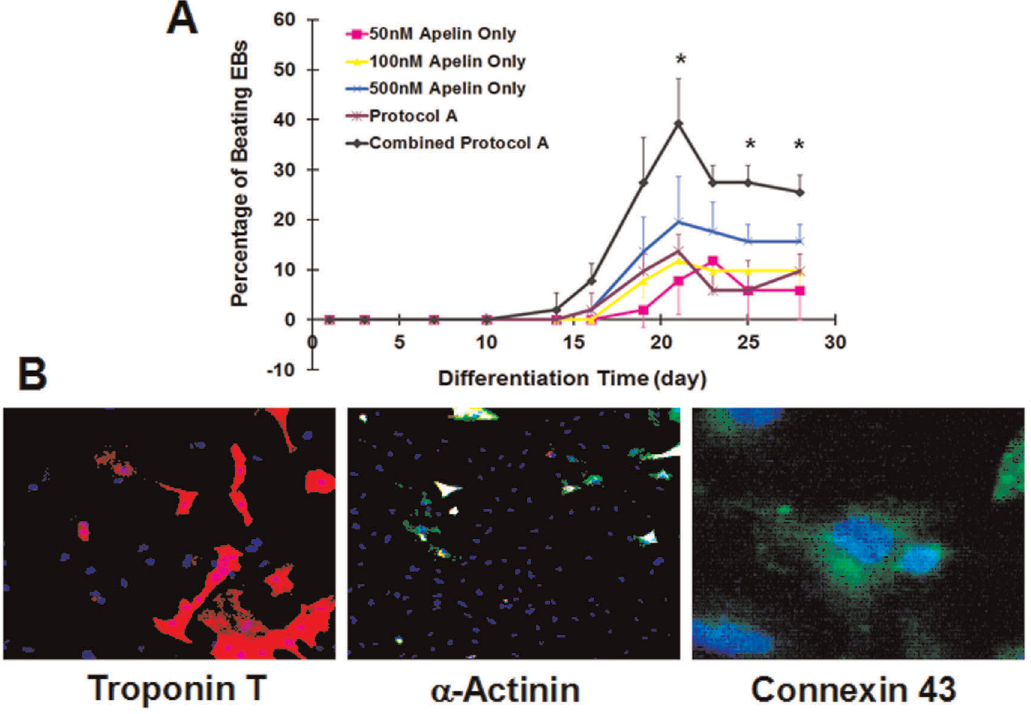
Figure 4. Effects of apelin on hEBs contractility and production of cardiac troponin-T, connexin 43 and a -sarcomeric actin. (A) Combined Protocol A demonstrates highest percentage of contractile hEBs compared to other protocols (*p , 0.05 for Combined Protocol A vs. other treatment groups), (B) Immunohistochemistry of cardiac troponin T (red stain), a -actinin (green stain), and connexin-43 (green stain) in 500 nM apelin only group on day 21 (blue stain: Hoechst nuclear